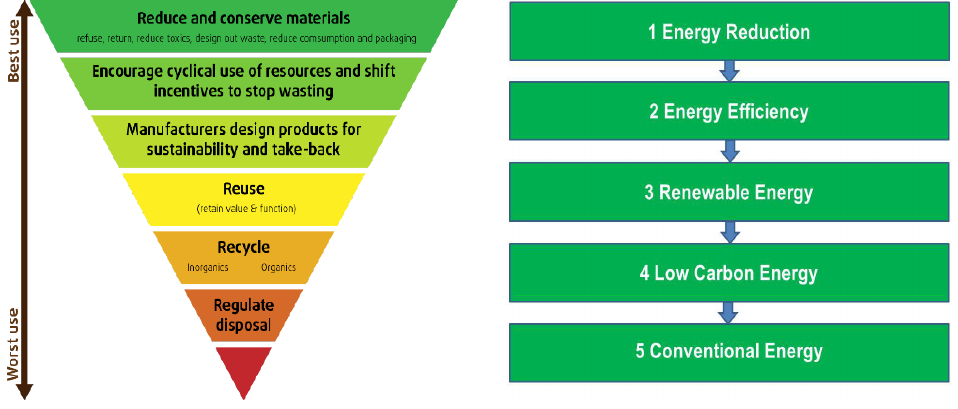
Figure 4. Two possible sustainability